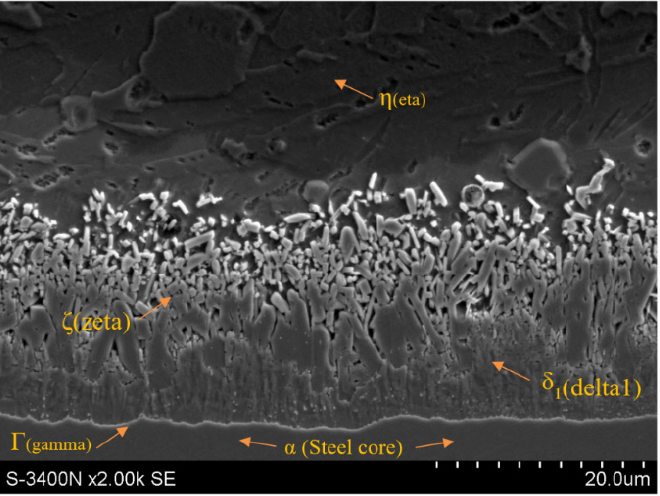
Figure 1. The microstructure of the zinc coating on the surface of the wire rod with the marks.